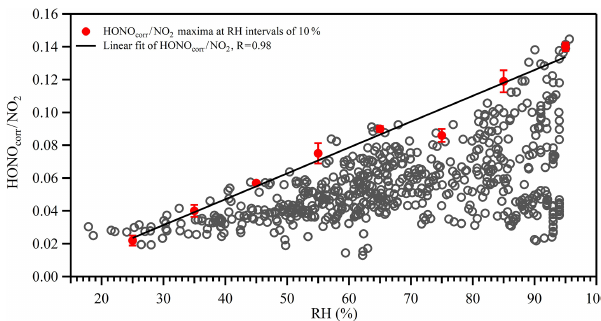
Figure 8. Correlation between HONO / NO 2 and relative humid- ity (RH) at night. The open gray circles are 30min averages. The red circles represent the averages of the top five maxima of the HONO / NO 2 ratios in 10% RH bins. Error bars represent standard deviations of the top five HONO / NO 2 ratios in 10% RH bins. The black line is the linear fit of the red circles for HONO / NO 2 with RH.